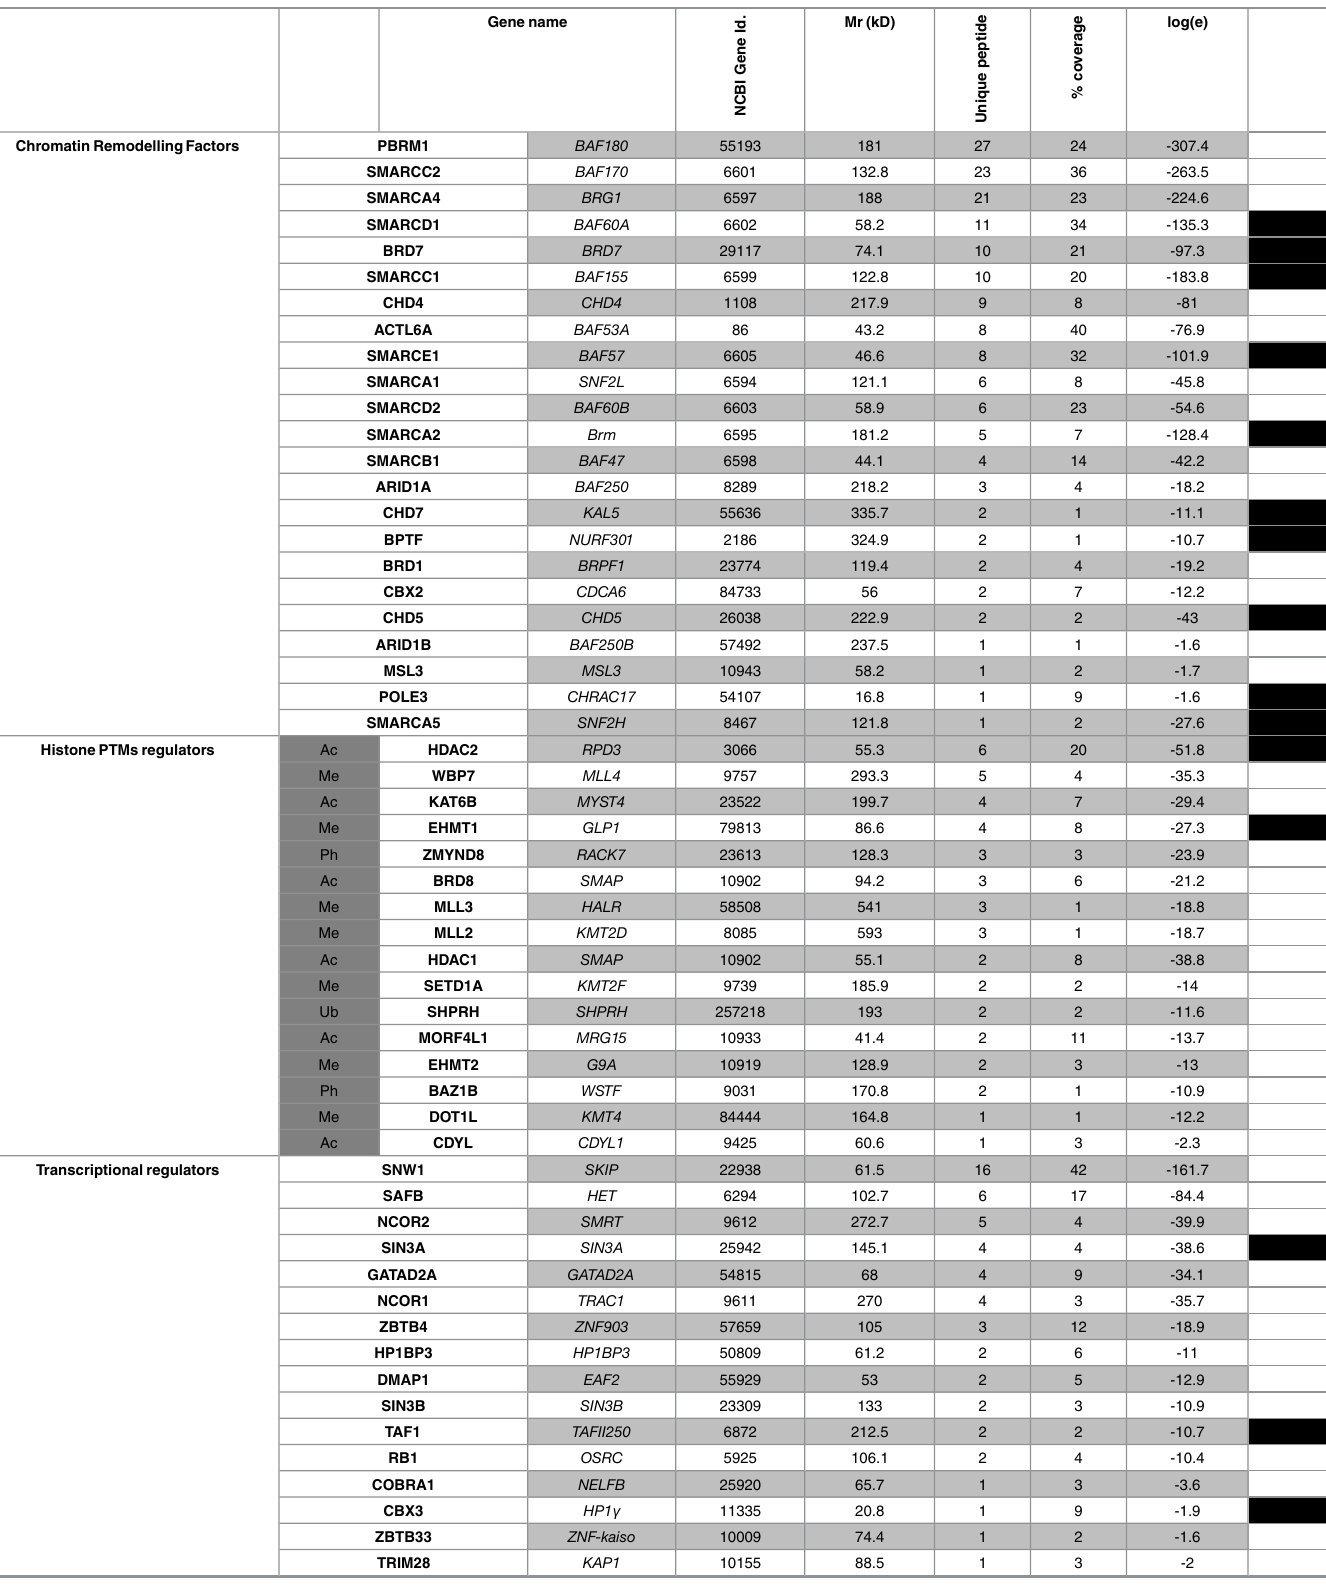
Table 1. Chromatinfactorsidentifiedby mass spectrometryas associated physically withthe spliceosome.